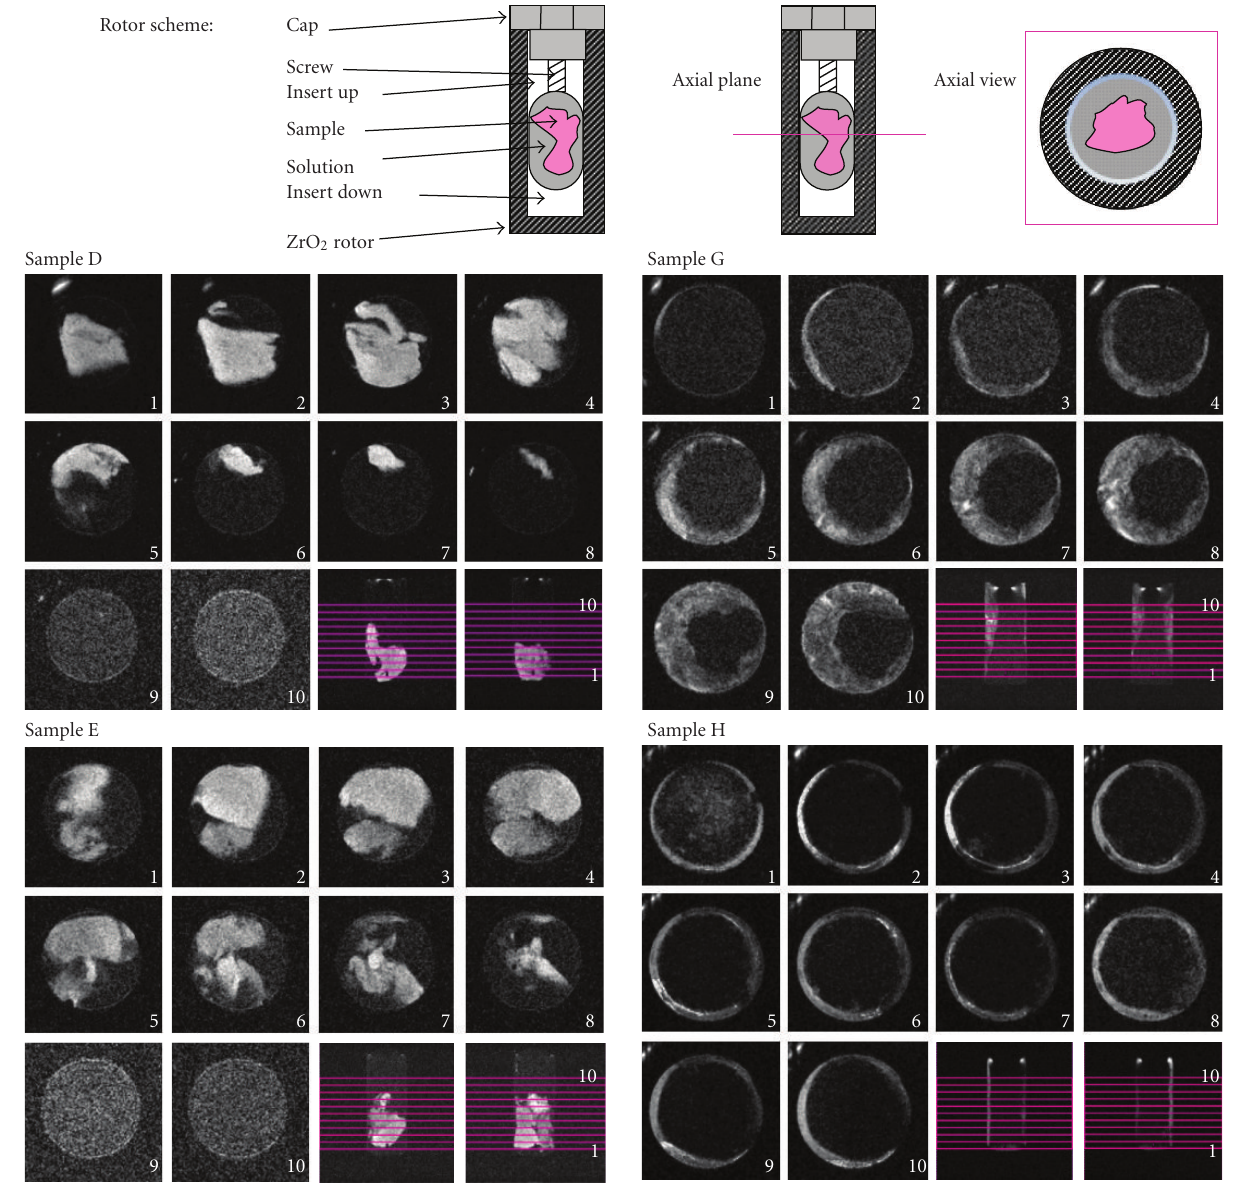
Figure 1: The upper part shows the scheme of a rotor containing the sample and the solution and the axial MRM images of four samples. The scheme of the HRMAS rotor shows the di ff erent parts with the sample and the solution in the inner cavity. The position of the axial plane is drawn with a magenta line and the axial view of the rotor on the right (upper part) shows the axial section, which is perpendicular to the longitudinal axis of the rotor. Below, the set of MRM images shows 10 RARE axial slices and the central sagital and coronal planes for each of the samples showing the shape of tissue pieces inside the rotor for samples D, E, G, and H. The position of the 10 axial images is detailed by the 10 magenta horizontal lines in the sagital and coronal planes in each sample. Axial images are zoomed to achieve the optimal view of the sample. In these MRM RARE images the solution, the rotor, and the air outside the rotor are darker than the